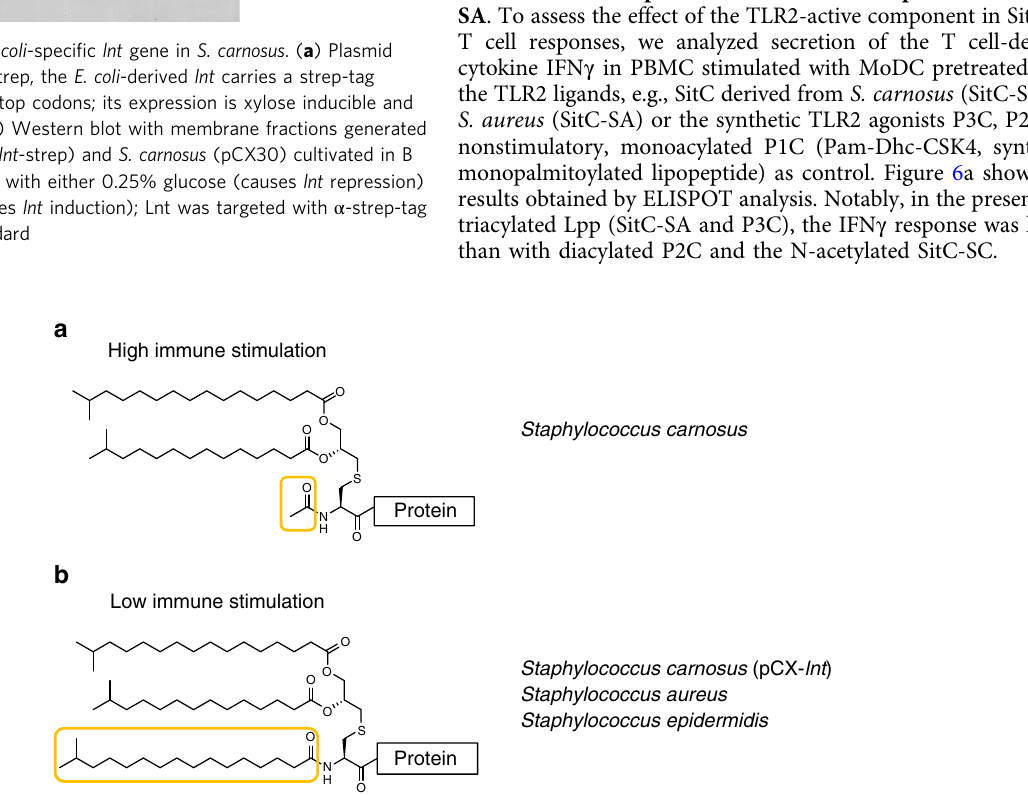
Fig. 4 The N -acetylated and N -long-chain-acylated triacyl structures of staphylococcal Lpp. The N -acetylation ( a ) is detected in S. carnosus , while the N -long-chain acylation ( b ) is found in S. aureus , S. epidermidis , and S. carnosus (pCX- lnt ). Representative structures of each type are shown. The long-chain acylation at the α -amino group of Lpp varies in length in S. aureus and S. epidermidis . In contrast, only heptadecanoyl group is detected in S. carnosus (pCX- lnt ). The sn-1 and sn-2 positions are O-acylated with various lengths of fatty acids (15:0 – 21:0) and exclusively O -pentadecanoic acid (15:0) in all